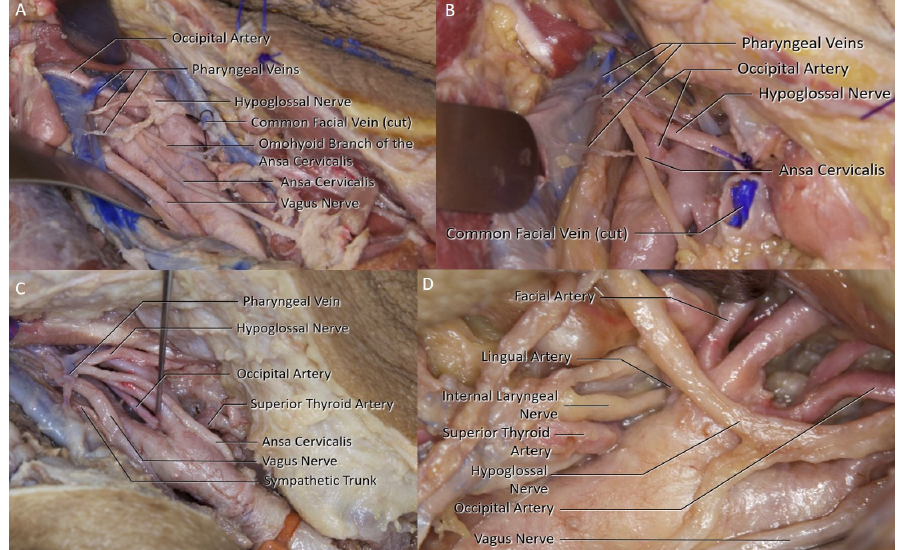
Figure 4. ( A ) Multiple pharyngeal veins can be seen on this right sided approach. ( B ) The right-side occipital artery can be seen pushing the HN away from the carotid bifurcation. ( C ) Right side pharyngeal vein can be seen intersecting the HN. ( D ) Left side HN can be seen neighboring the carotid bulb, an ansa cervicalis division may be required for sufficient mobilization of the